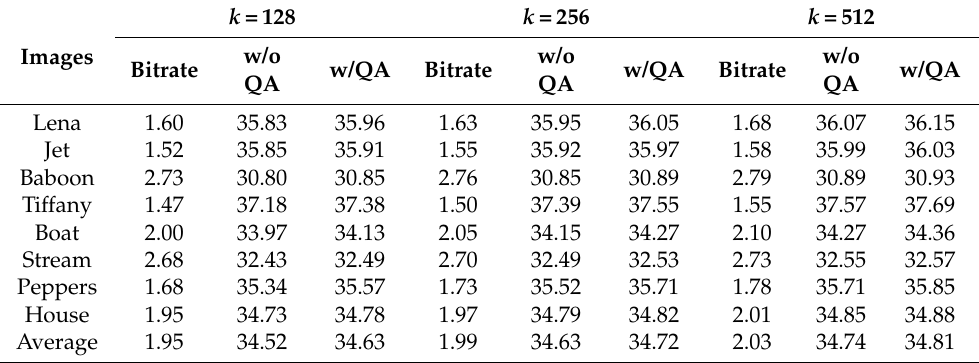
Table 2. Peak signal-to-noise ratio (PSNR) and bitrate of compressed images with 4 × 4 block size.